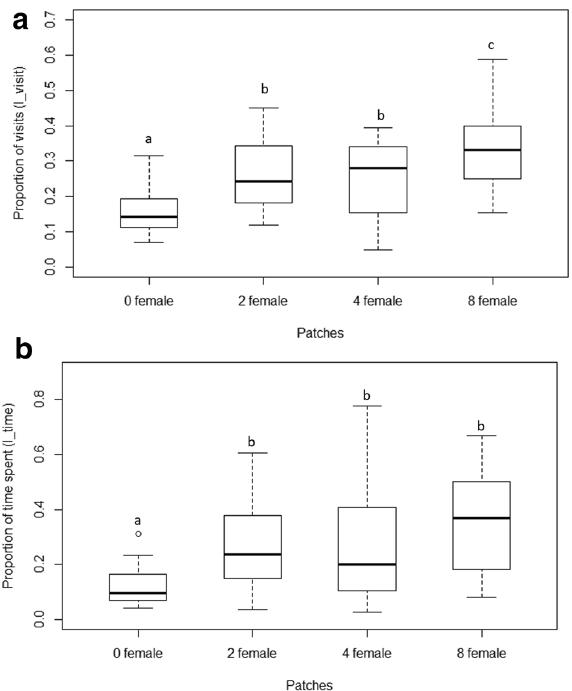
Figure 3. ( a ) Boxplots showing the proportion of visits (I_visit) by the male to the various chambers (patches) containing females in varying density. The chamber containing no females received a significantly lesser number of visits compared to the other three chambers. The eight female patch received higher proportion of visits compared to two and four female patches. Differing alphabets indicate statistical significance (p < 0.05), while similar alphabets indicate no statistical difference. The lower and upper ends of the box plots represent the 1st and 3rd quartiles, the horizontal line within each boxplot is the median, and the upper and lower whiskers are the ×1.5 the interquartile range. Outlines are shown as open circles. ( b ) Boxplots showing proportion of total time (I_time) spent by the male in each of the chambers. Males spent significantly longer time in the three female-containing chambers compared to the chamber with no females. They spent similar proportions of time in 2, 4 and 8 female patches. Differing alphabets indicate statistical significance between the two plots (p < 0.05). The lower and upper ends of the box plots represent the 1st and 3rd quartiles, the horizontal line within each boxplot is the median, and the upper and lower whiskers are the ×1.5 the interquartile range. Outlines are shown as open